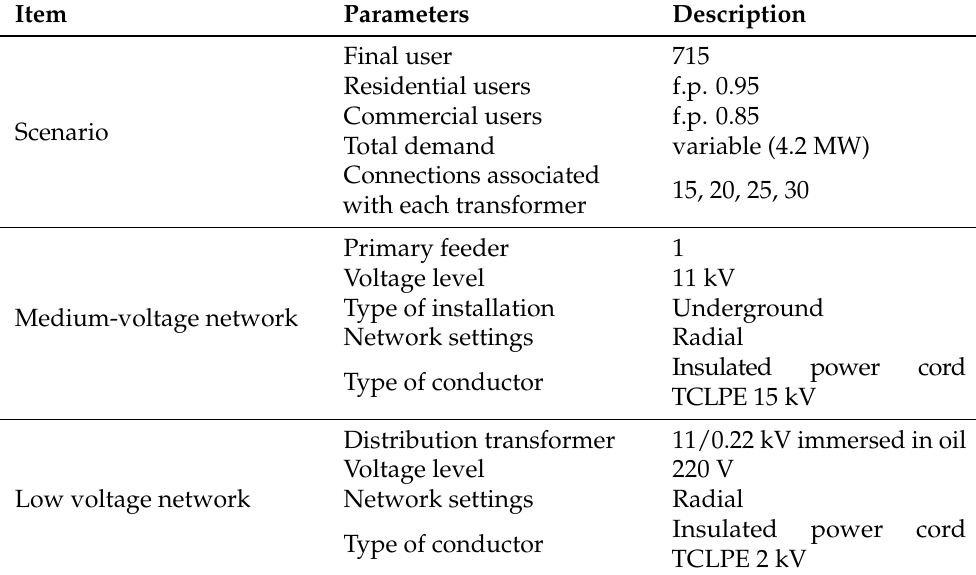
Table 5. Characteristics of the final scenario for analysis of the method.